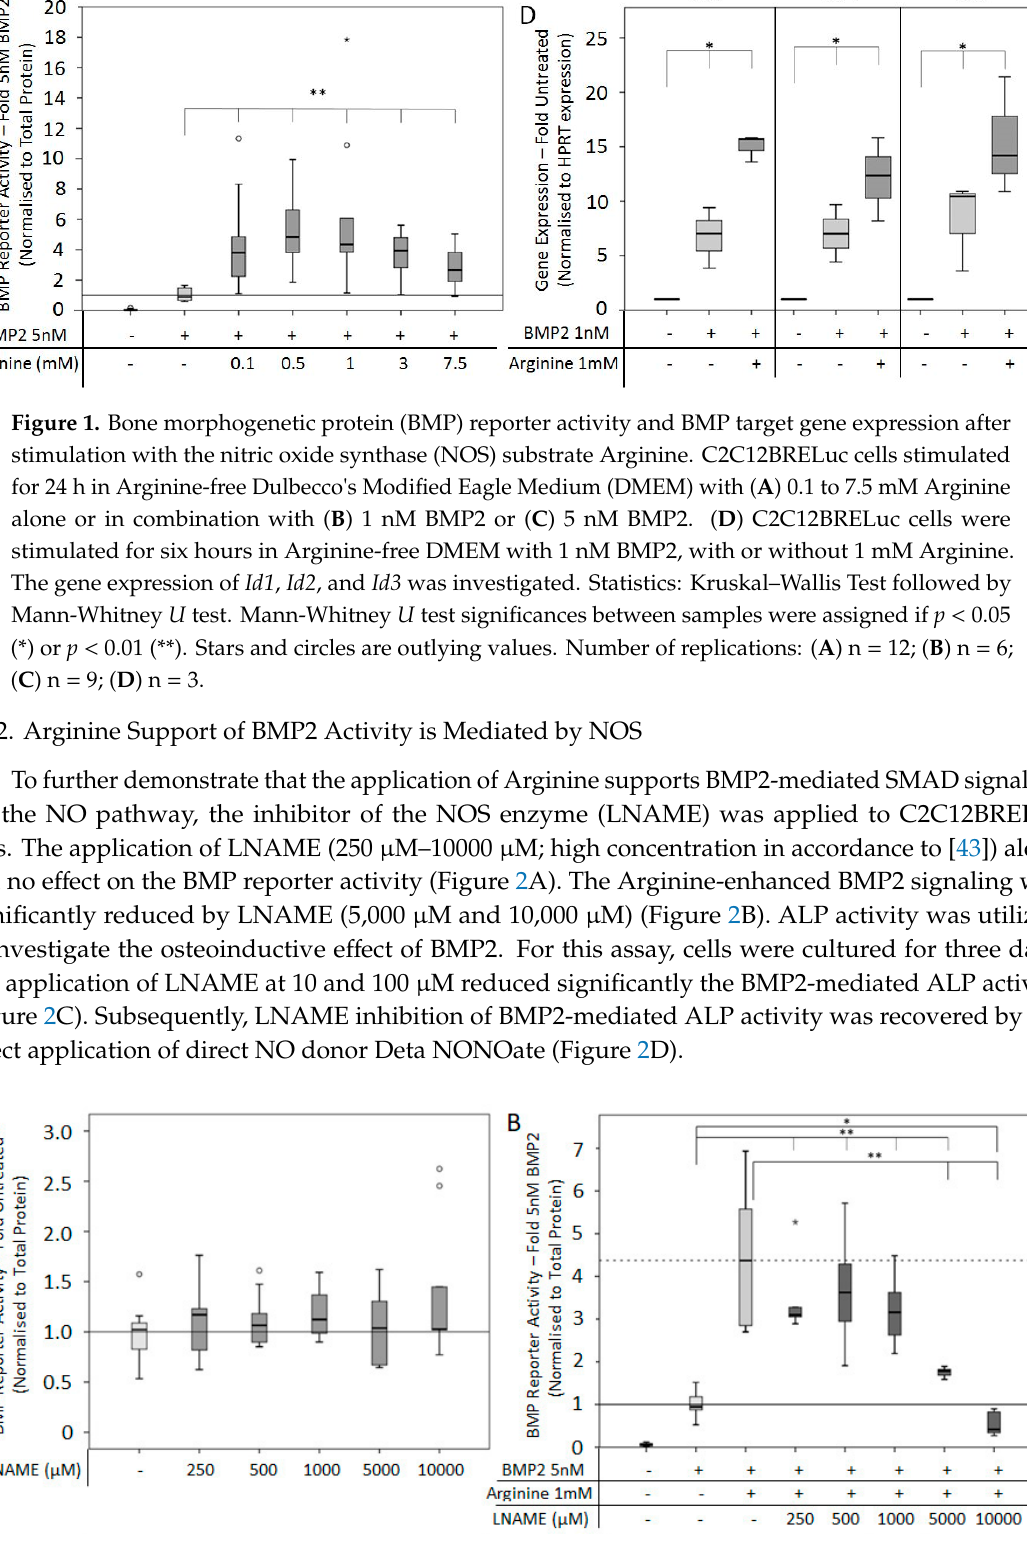
Figure 2. BMP reporter and alkaline phosphatase activity (ALP) activity following the inhibition of NOS enzyme by NOS inhibitor (LNAME): C2C12BRELuc cells were stimulated for 24 h with ( A ) 250- 10,000 μ M LNAME or ( B ) 5 nM BMP2 and 1 mM Arginine in combination with 250-10,000 μ M LNAME. ALP activity was normalized to cell number of cells stimulated for 72 h with 10 nM BMP2 with ( C ) NOS inhibitor LNAME (0.01 to 100 μ M) and ( D ) following recovery of 10 μ M or 100 μ M LNAME inhibition with the direct NO donor. Statistics: Kruskal–Wallis Test followed by Mann- Whitney U test. Mann-Whitney U test significances between samples were assigned if p < 0.05 (*) or p < 0.01 (**) or p < 0.001 (***). Stars and circles are outlying values. Abbreviation: Deta: Deta NONOate. Number of replications: ( A – D ) n = 6. 3.2. BMP2-Mediated Signaling and Osteogenesis Can be Enhanced by Direct NO Donor